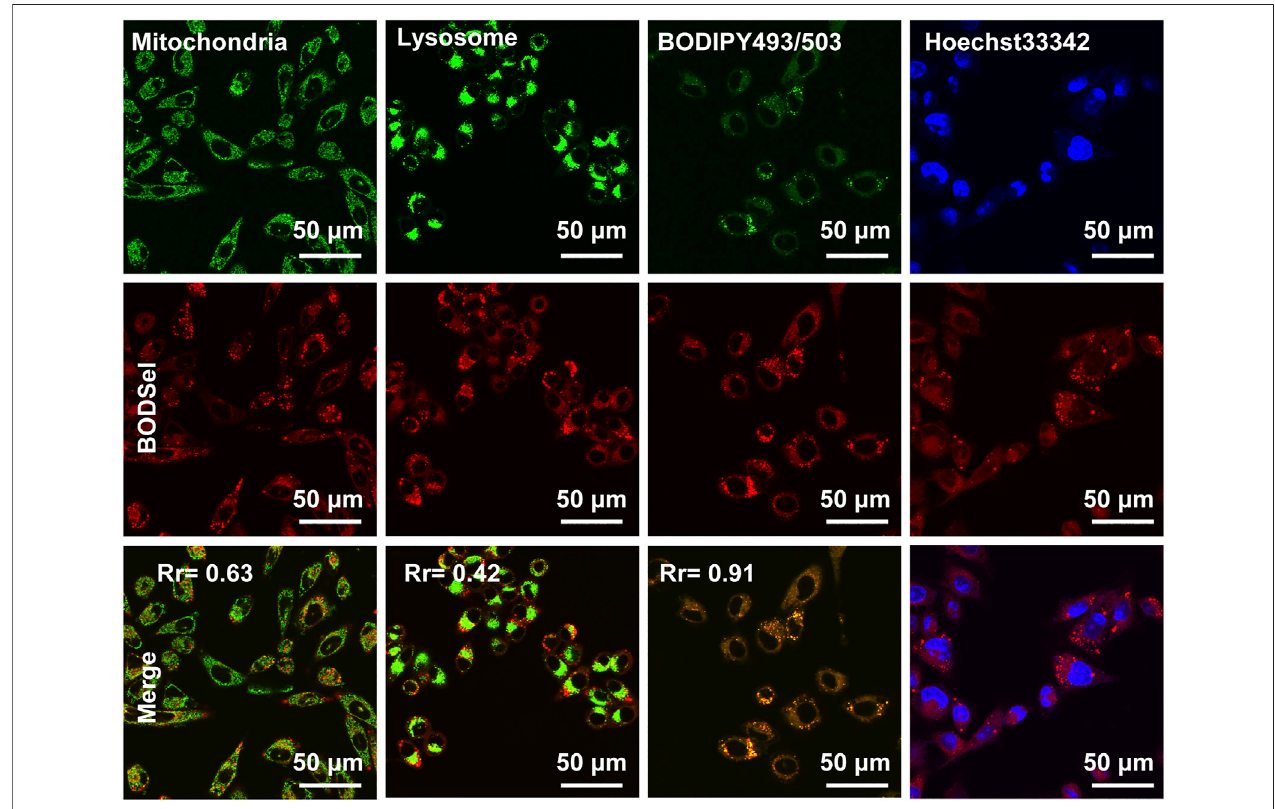
FIGURE 4 | Co-localization imaging of MCF-7 cells. The cells were incubated with BODSeI at 37 ° C for 30 min in the serum-free medium, then treated with commercial fl uorescence dyes at 37 ° C for another 30 min, and fi nally washed with PBS three times before confocal imaging. From top to bottom lines are commercial dyes, BODSeI, and merge channel. The concentration and excitation/emission wavelengths are provided in parentheses as follows: BODSeI (1 μ M, λ ex (cid:1) 546 nm, λ em : 560 – 600 nm), MitoTracker Green (0.5 μ M, λ ex (cid:1) 488 nm, λ em : 500 – 540 nm), LysoTracker Green (0.5 μ M, λ ex (cid:1) 488 nm, λ em : 500 – 540 nm), BODIPY493/503 (0.5 μ M, λ ex (cid:1) 488 nm, λ ex (cid:1) 500 – 530 nm), and Hoechst33342 (0.5 μ M, λ ex (cid:1) 405 nm, λ em : 430 – 470 nm), respectively. Scale bar: 50 μ m. The Pearson correlation coef fi cient (Rr) was calculated by Olympus FV3000 software